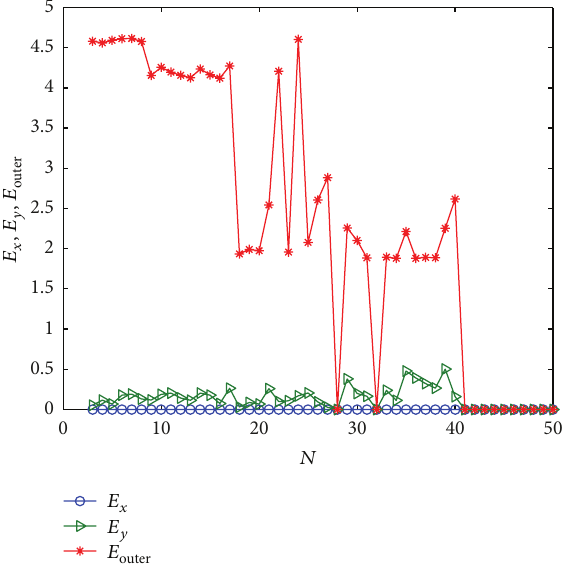
at 𝑡 = 400 regarding 𝑁 outer